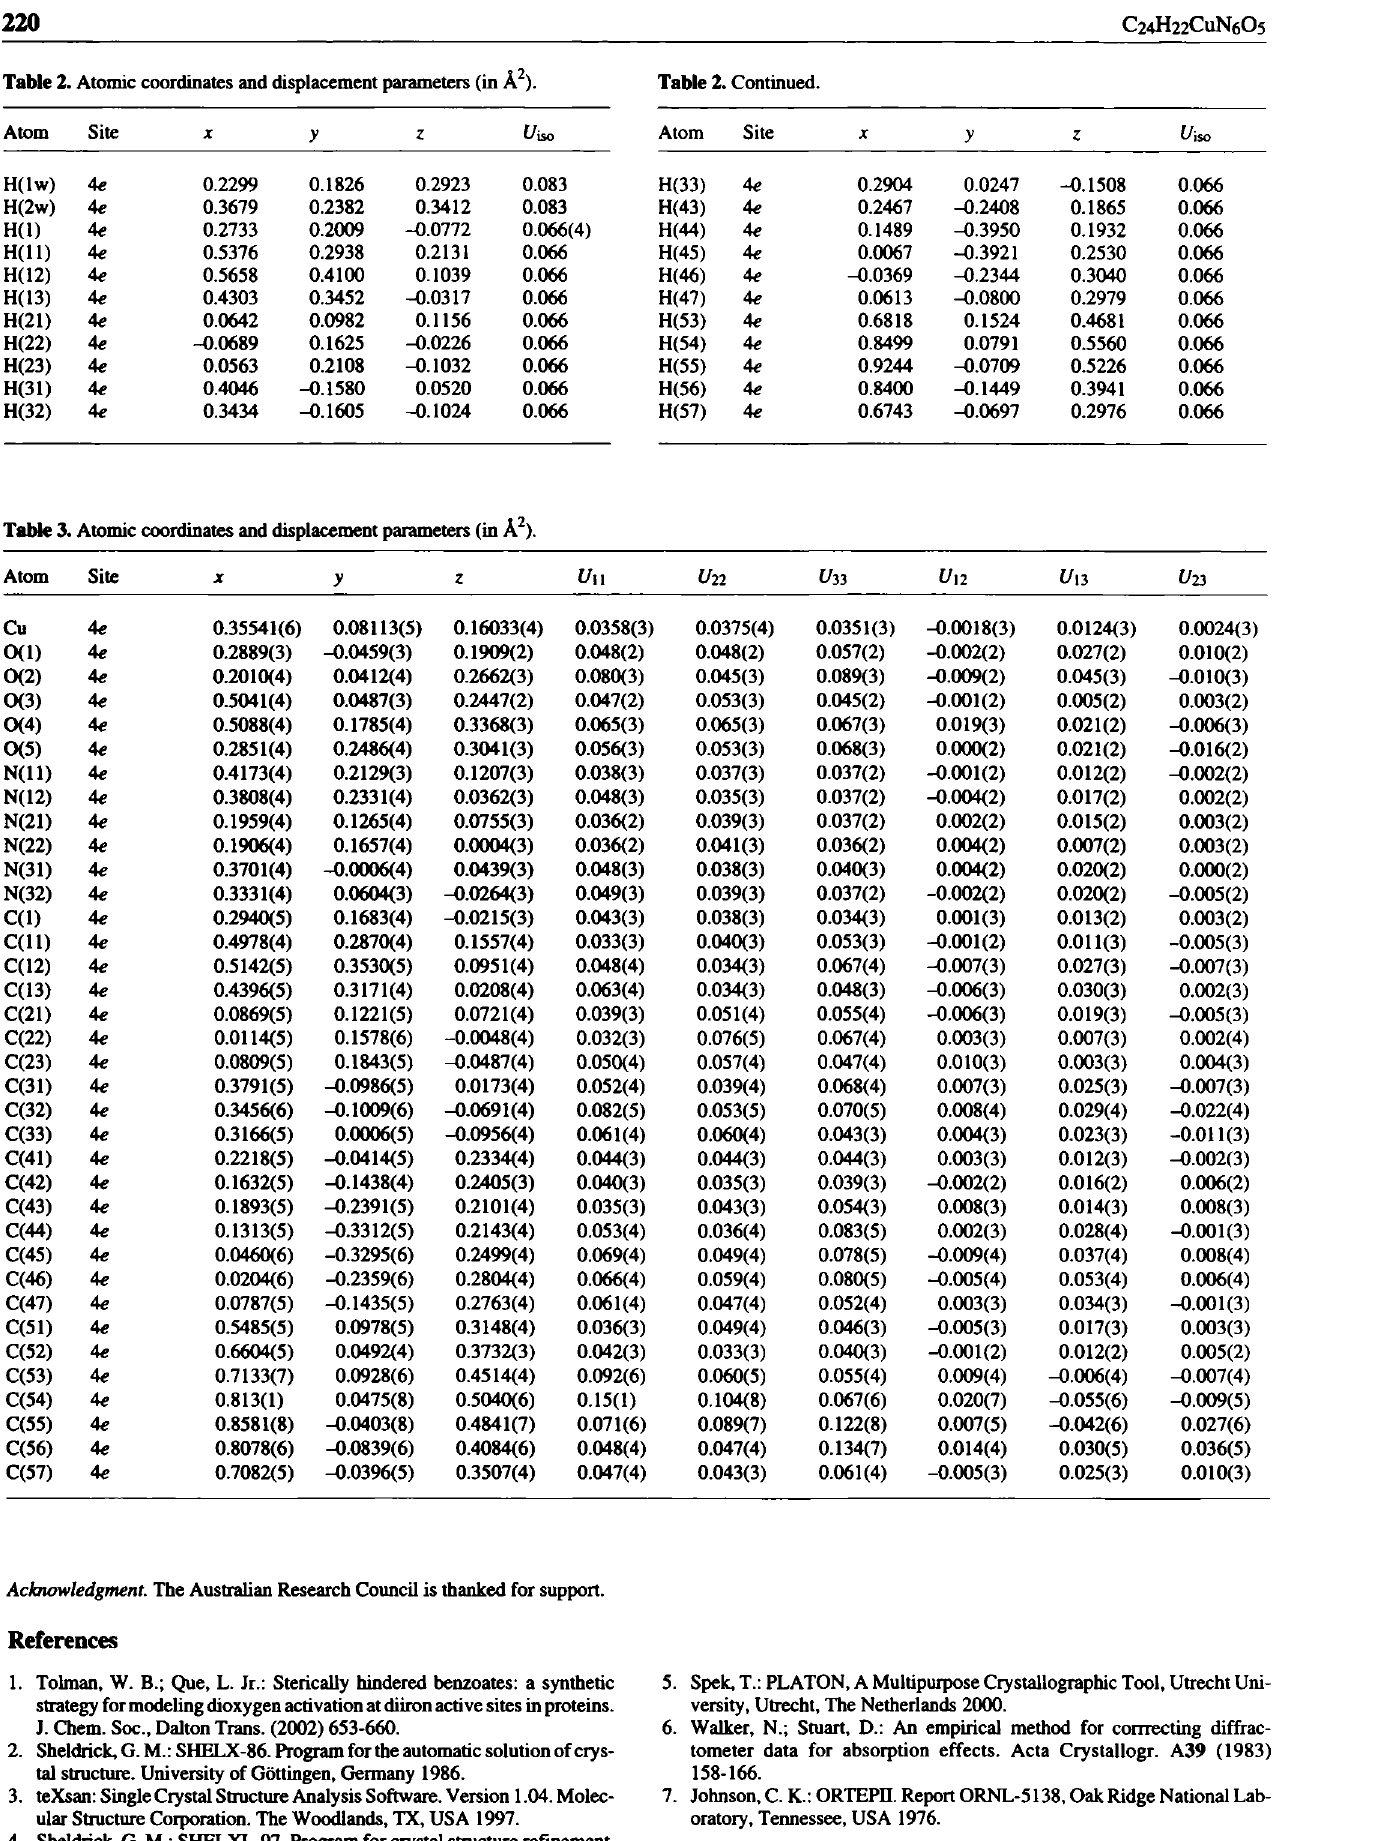
Table 2. Atomic coordinates and displacement parameters (in Â 2 ).